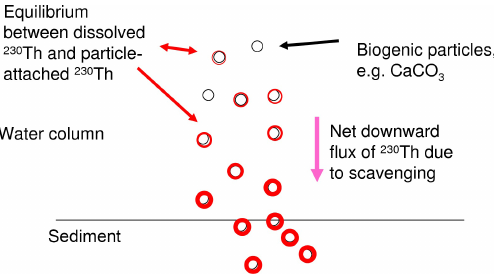
Figure 1. Schematic illustration of the equilibration process be- tween the dissolved and particle-attached phases of 230 Th and the increasing concentrations downward in the water